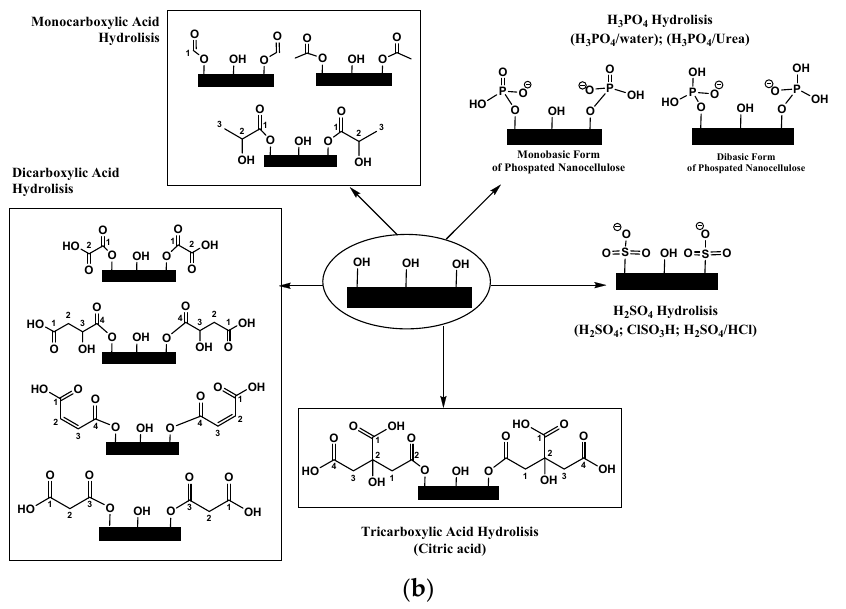
Figure 6. Simplified mechanisms of chemical synthesis nanocellulose; ( a ) acid-based chemical modification; ( b ) oxidation based chemical modification. Table 4. The influence of chemical functionalization on morphological nanocellulose.